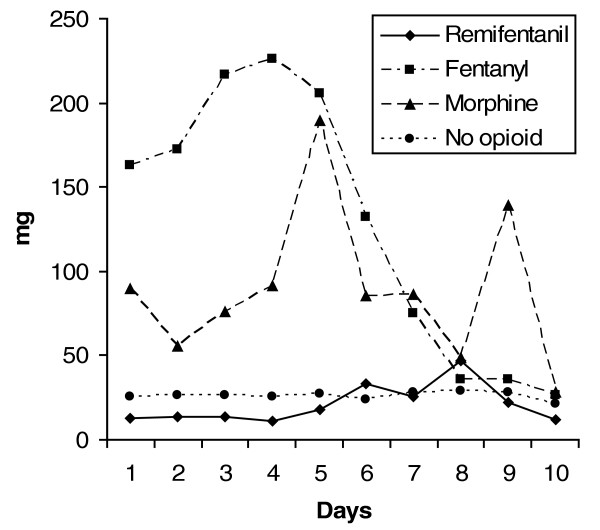
Mean total daily dose of midazolam with concomitant opioids.